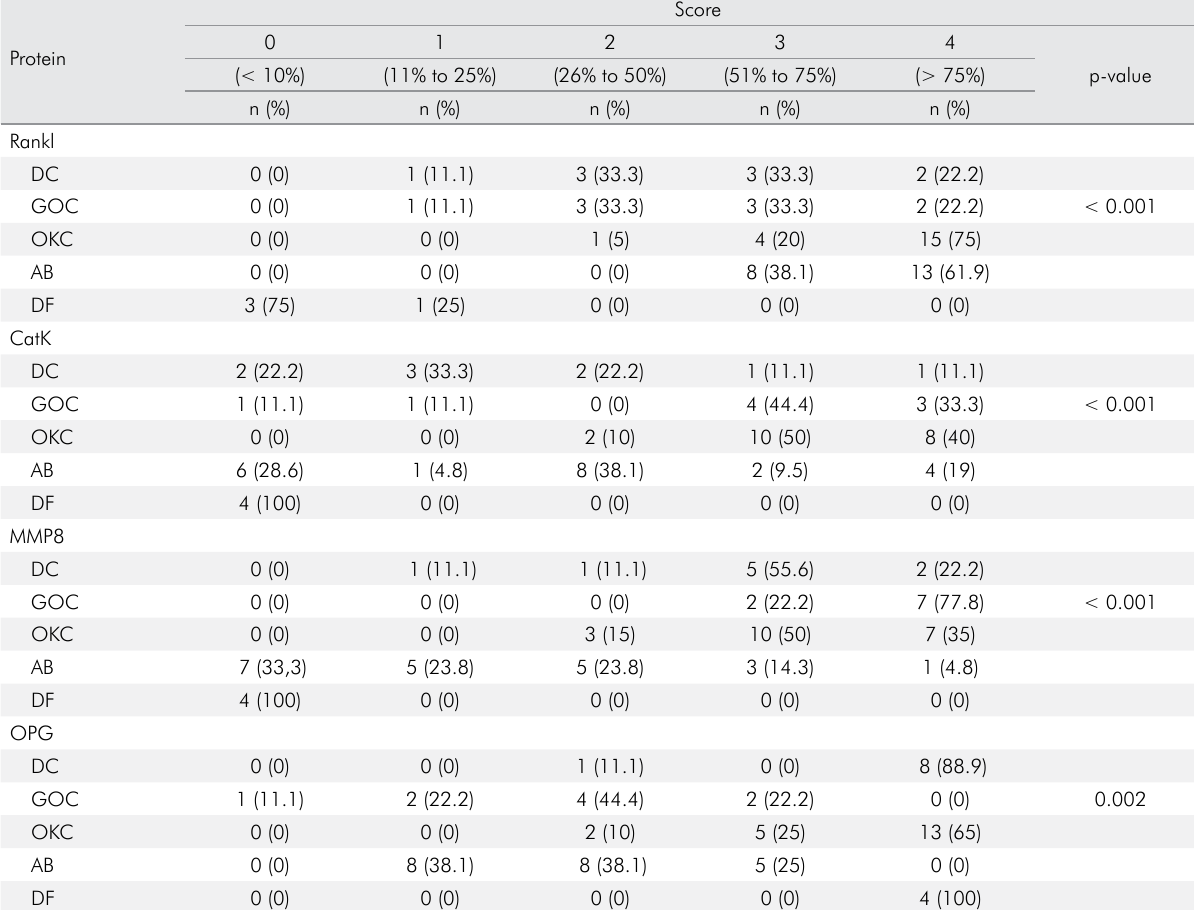
Table 1. Comparison of epithelial expression of the proteins studied in dentigerous cyst, glandular odontogenic cyst, odontogenic keratocyst, ameloblastoma, and dental